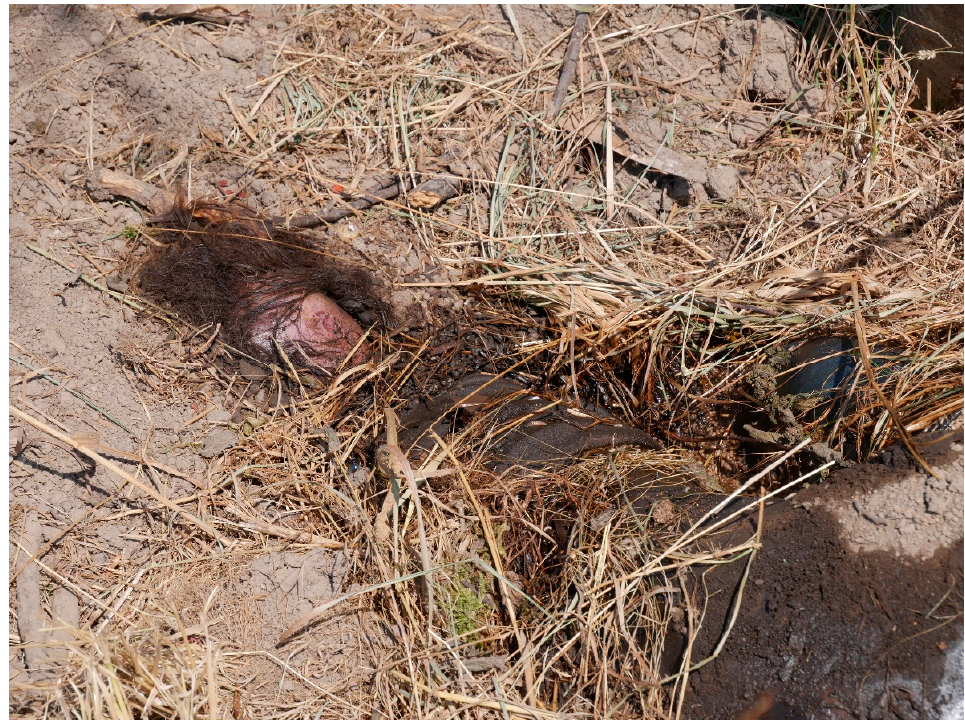
Figure 1. Partly skeletonized human remains found at the edge of a cornfield.